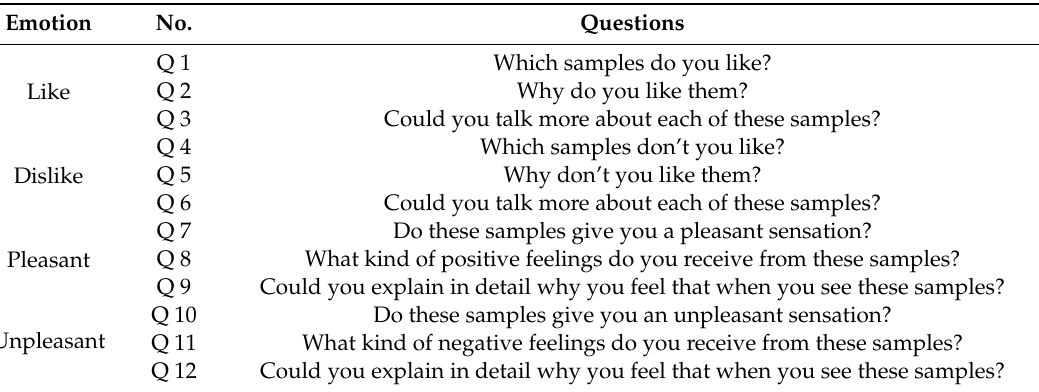
Table 1. Example Interview Questions.